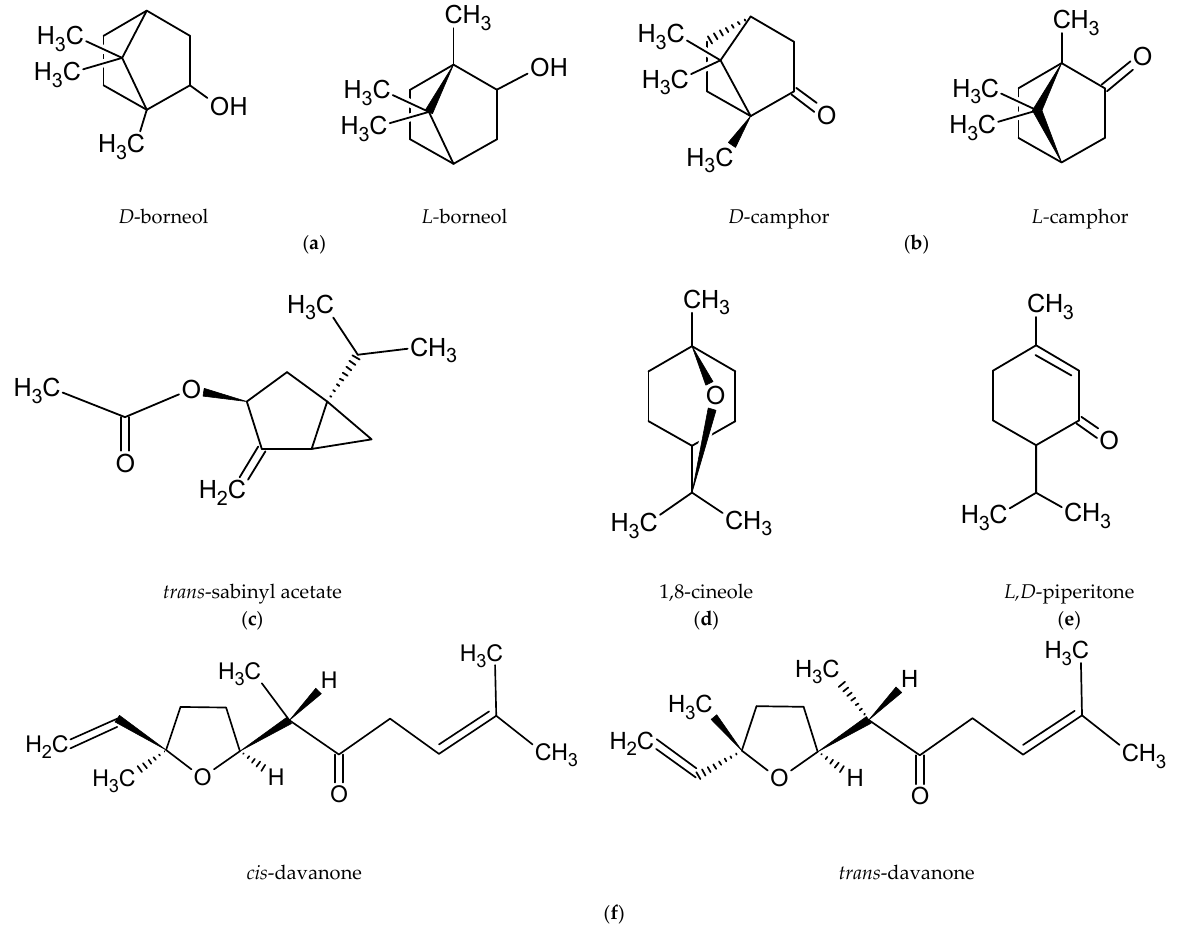
Table 2. Chemical composition of A. abrotanum .